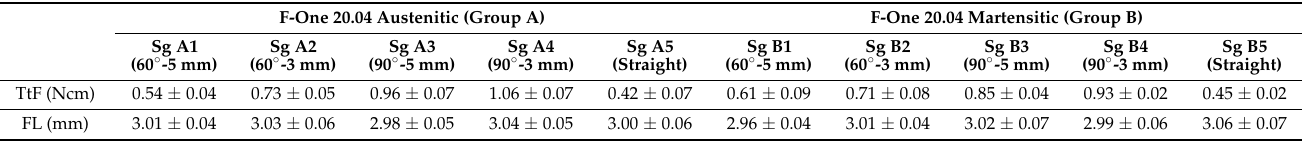
Table 1. Summary of the results of TtF and FL with mean values and standard deviations according to the different bending conditions and crystallographic phases. The angle and the radius of curvature are specified in brackets. (Sg = Subgroup). F-One 20.04 Austenitic (Group A) F-One 20.04 Martensitic (Group